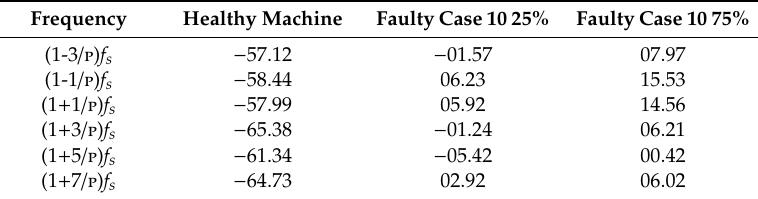
Table 10. Current harmonic components comparison due to case 10 (in